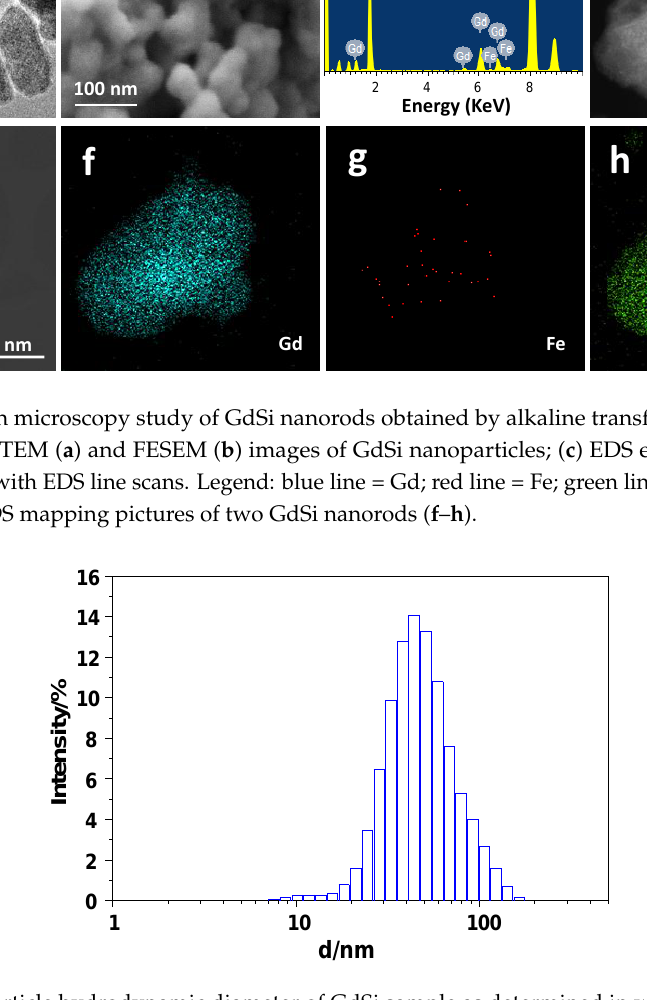
Figure 4. Particle hydrodynamic diameter of GdSi sample as determined in water by DLS.